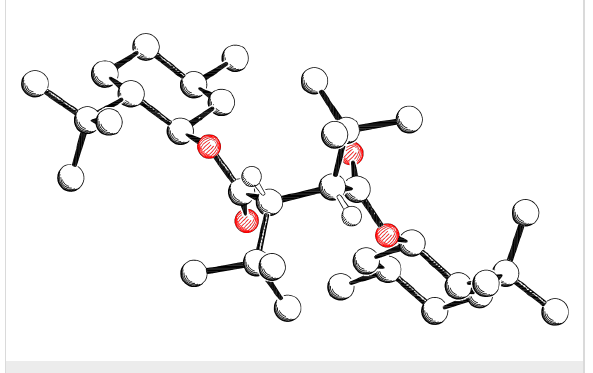
Figure 4: Crystal structure of major diastereomer 28a .